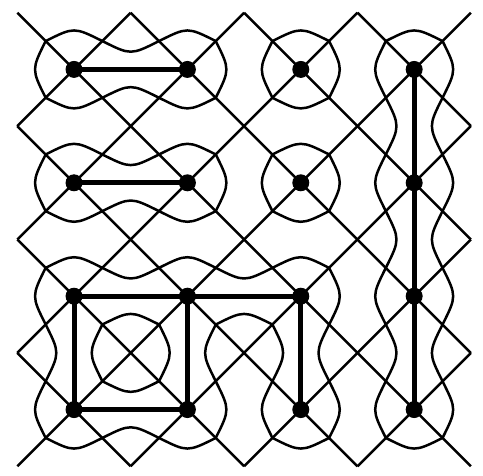
Figure 2 . The one-to-one mapping between cluster con(cid:12)gurations and loop con(cid:12)gurations. two binary choices: 1) For tiles of type (a) and (c), the Potts spins (resp. dual Potts spins) stand at the top and bottom vertices (resp. at the left and right vertices) of the tile, while it is the other way around for tiles of type (b) and (d). 2) For tiles of type (a) and (b), the FK expansion contains a line between the two Potts spins, while for tiles of type (c) and (d) there is no such line. A loop representation equivalent to the FK one is now